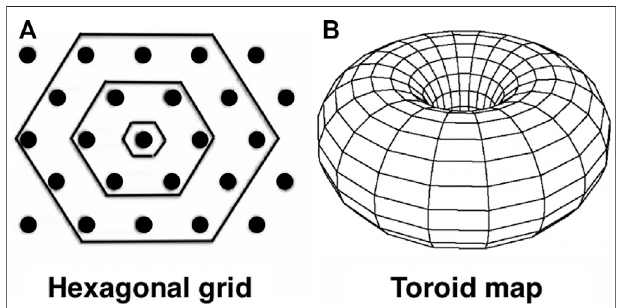
FIGURE 4 | Examples of a local hexagonal lattice structure (A) , and a global toroid map shape (B) . In this article the toroid shape, visualized as sheet, is used (see Results section).